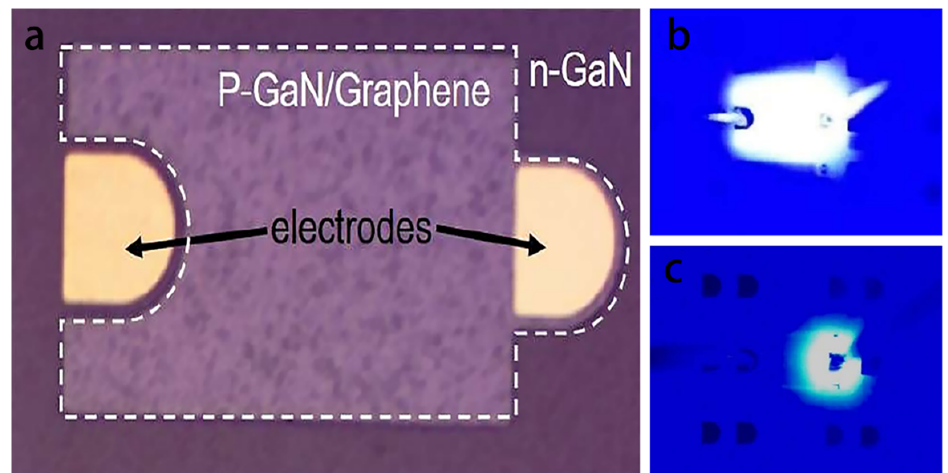
Figure 15. ( a ) Physical diagram of graphene transparent conductive layer GaN LED device. ( b , c ) Comparison of luminescence of GaN LEDs with and without graphene: ( b ) Luminescence with gra- phene; ( c ) No